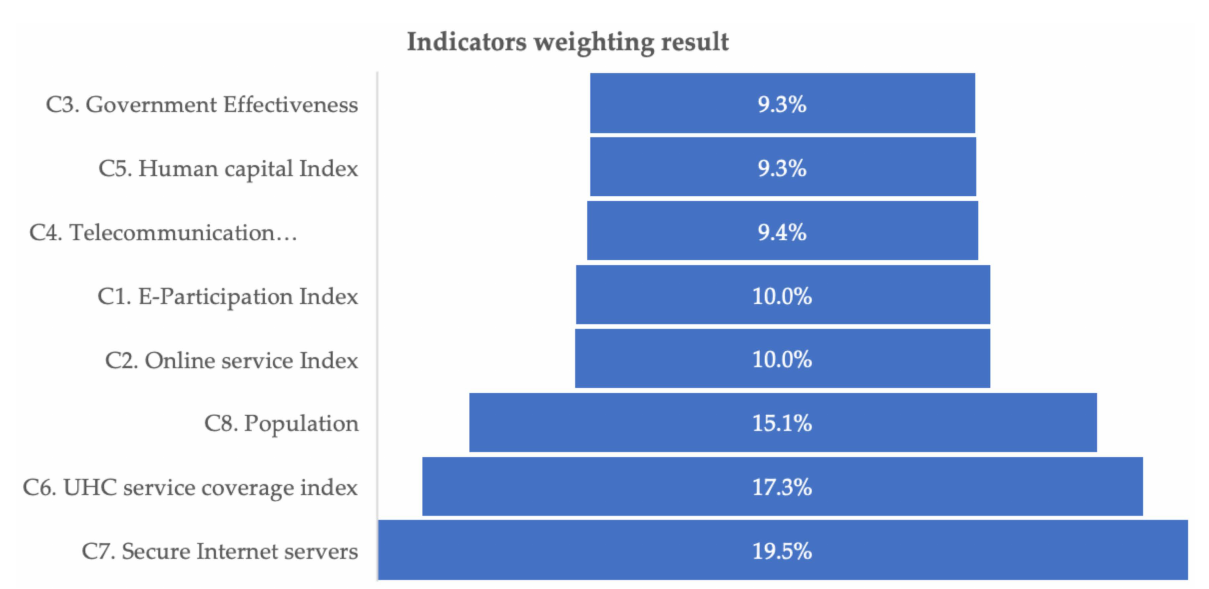
Figure 2. Indicators weighting